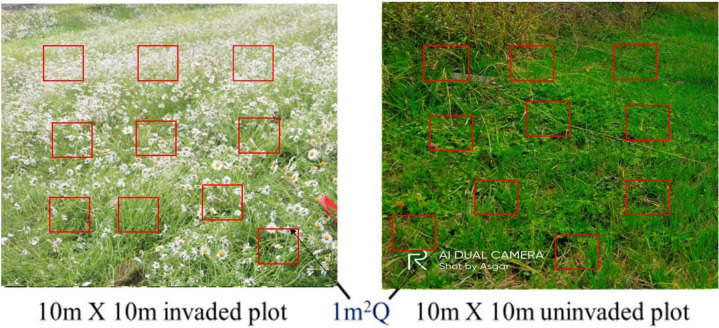
Design of the experimental plots showing 1m2 quadrats in 10m x 10 m plots.